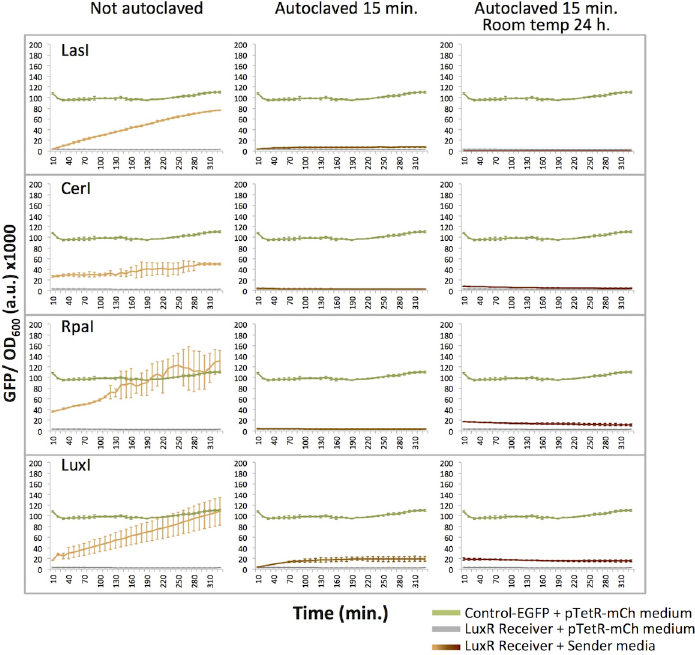
Fig 7. Autoclaving deactivates media containing homoserine lactones (HSLs). Induction of the LuxR receiver device with untreated or treated media from LasI, CerI, RpaI, and LuxI Sender cultures. Treated cultures were autoclaved for 15 min. and used to induce LuxR receiver cultures immediately or after a 24 h incubation at room temperature.